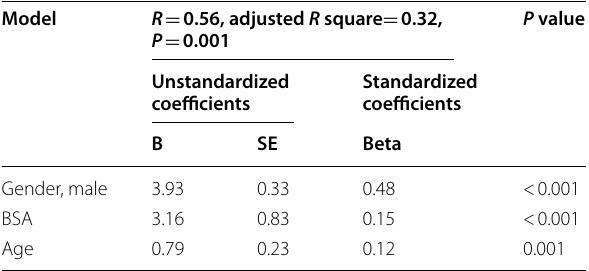
Table 26 Linear regression analysis to predict aortic sinus diameter Model